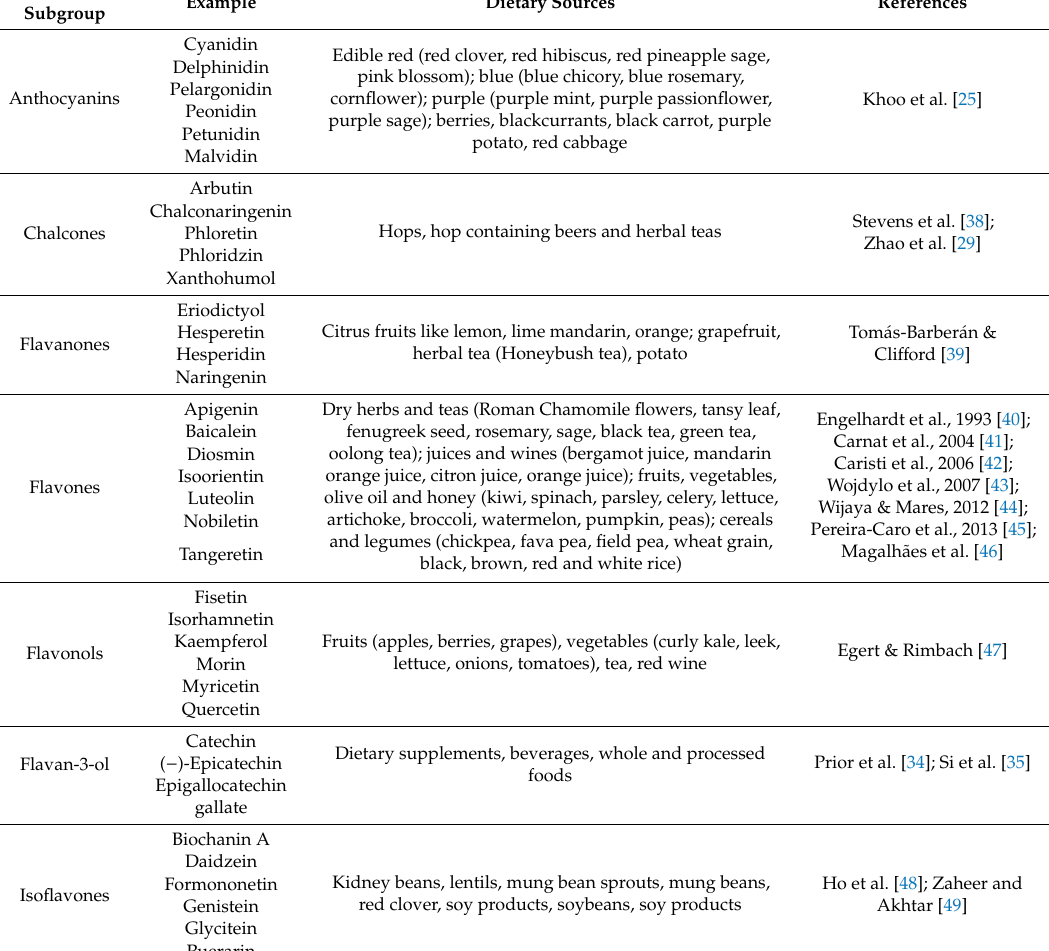
Table 2. Di ff erent sub-groups, examples, and dietary sources of